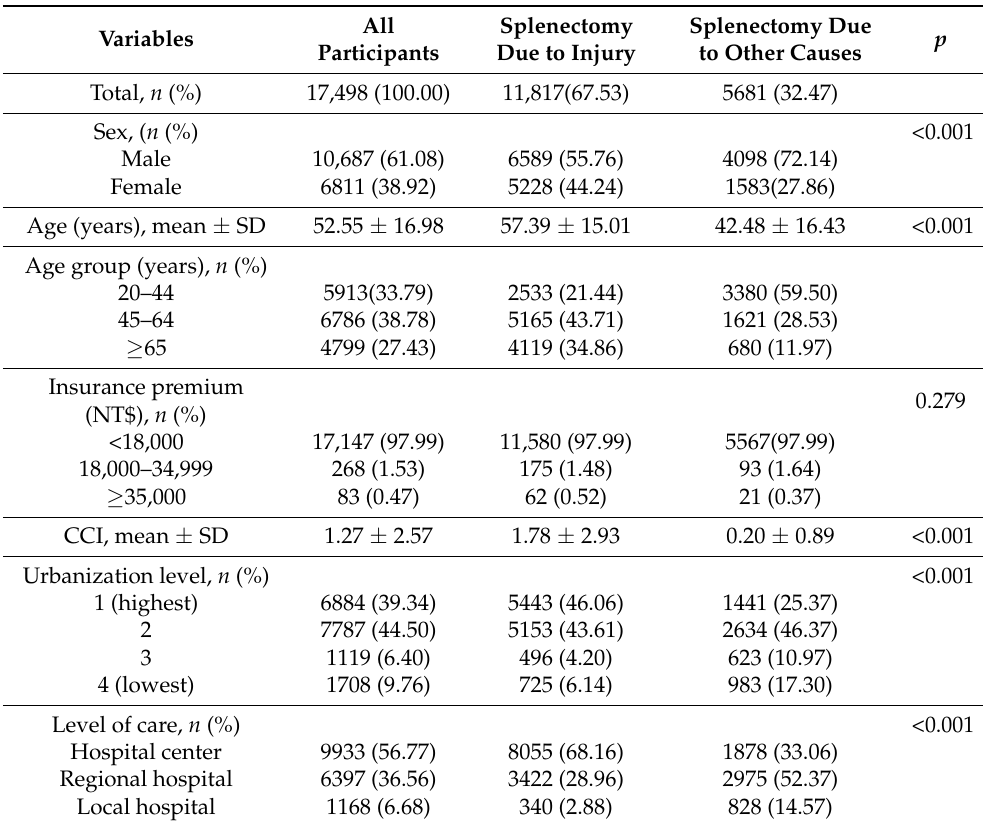
Table 1. Baseline characteristics of study